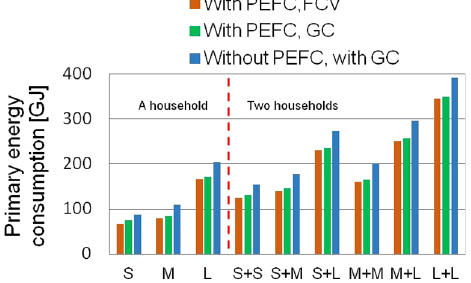
Fig. 10. Primary energy consumption.